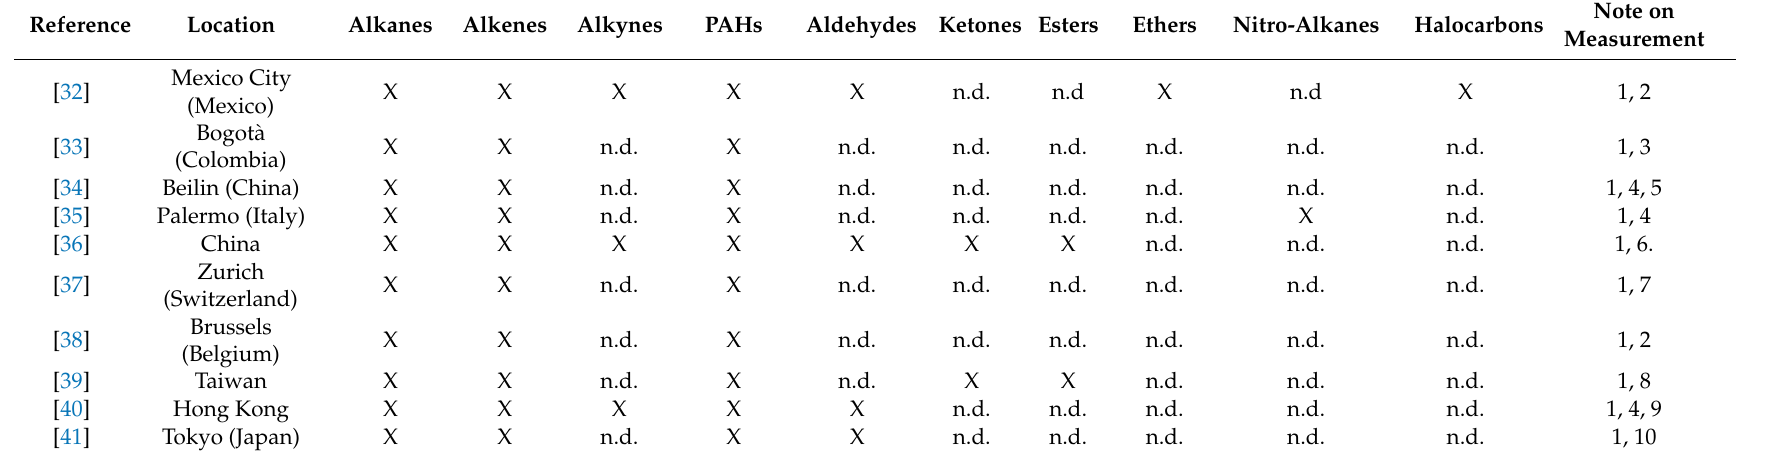
Table 4. Review of existing studies characterizing VOC emissions from tra ffi c